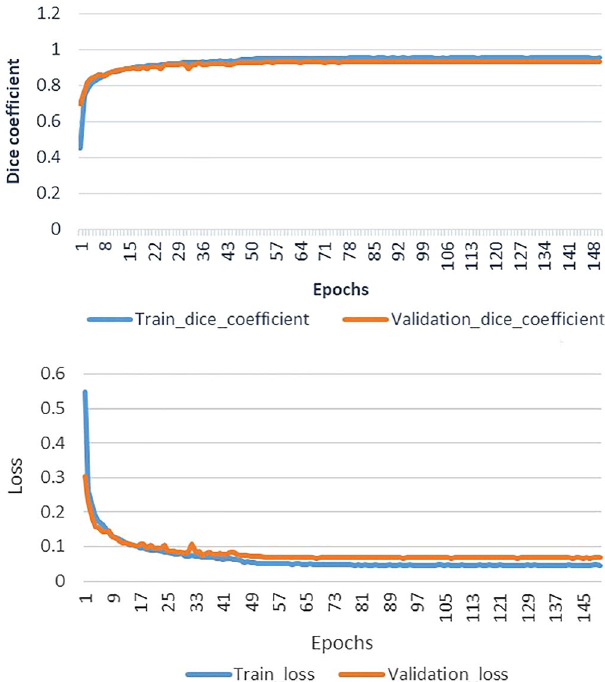
Figure 7. Training and validation dice accuracy and loss plots for the proposed architecture for the CRL